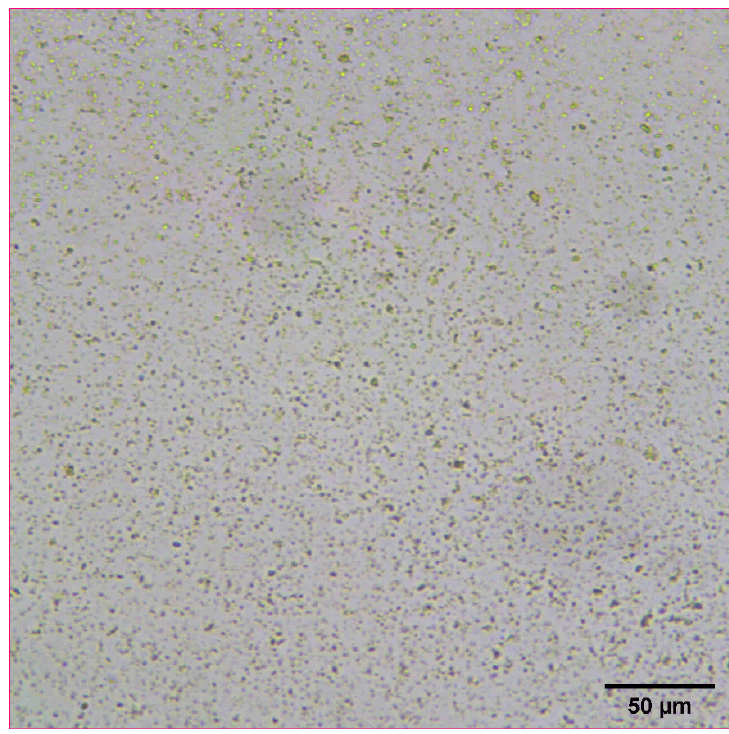
Figure 8. Optical microscope image of 10 mg/mL concentration naproxen nanosuspension after inkjet printing onto a film transparency. A drop of water was added to observe the redispersion of the dried nanosuspension droplets.